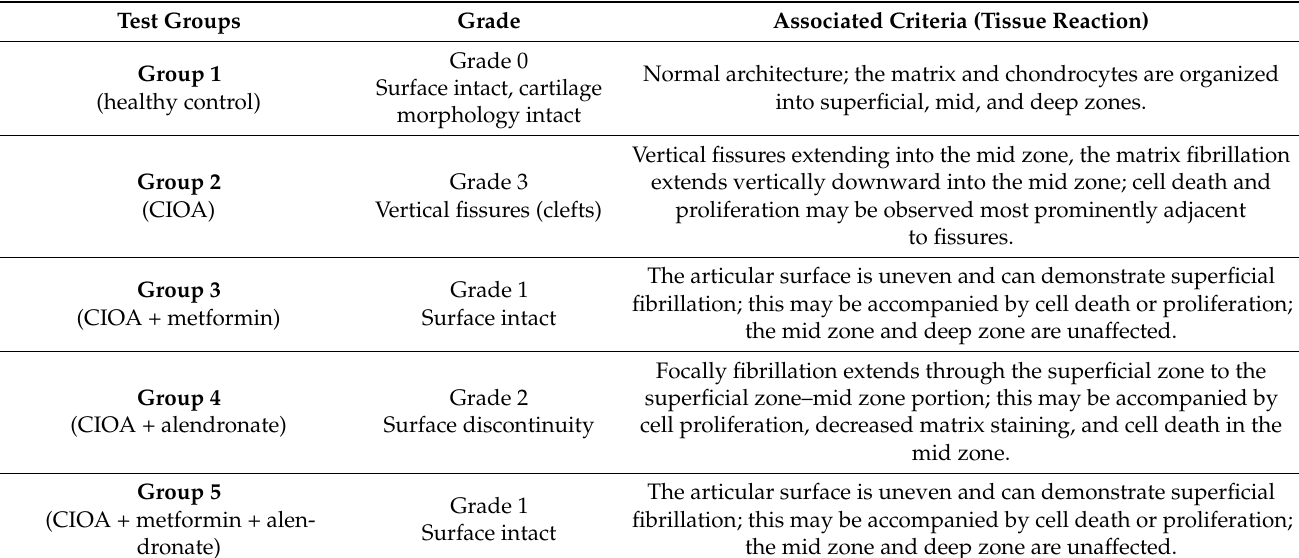
Table 1. Grade * of the histopathological alterations in the tested groups according to Pritzker et al. (2006). Test Groups